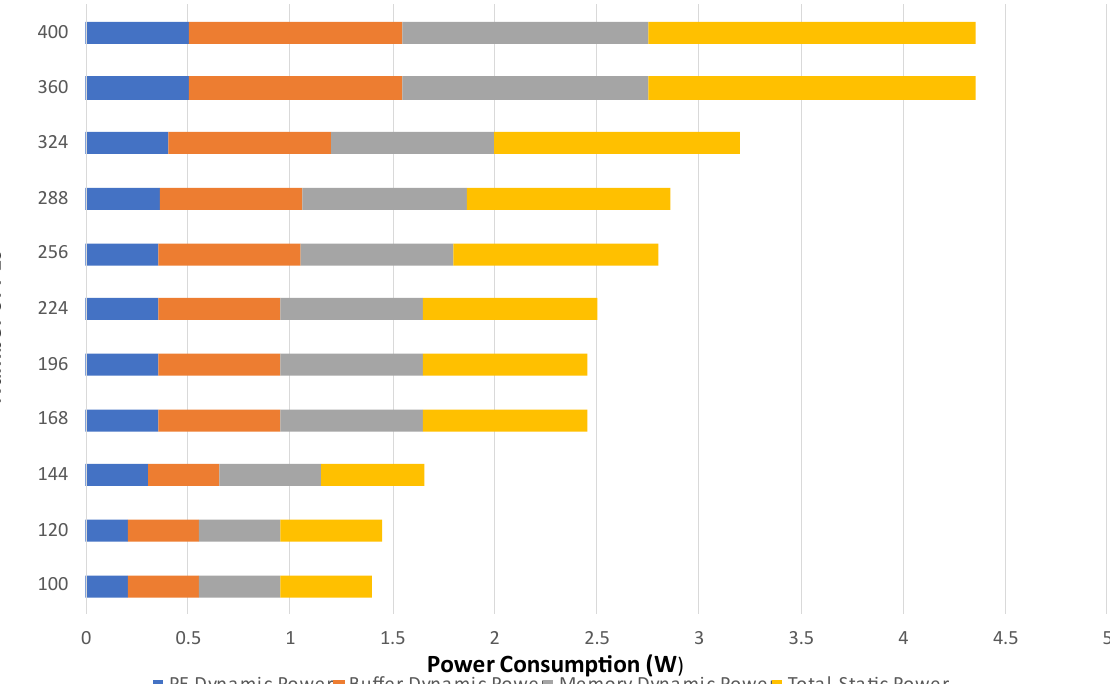
Figure 5. The PE array sizes running VGGNET on Eyeriss under optimal scheduling for power con- sumption.